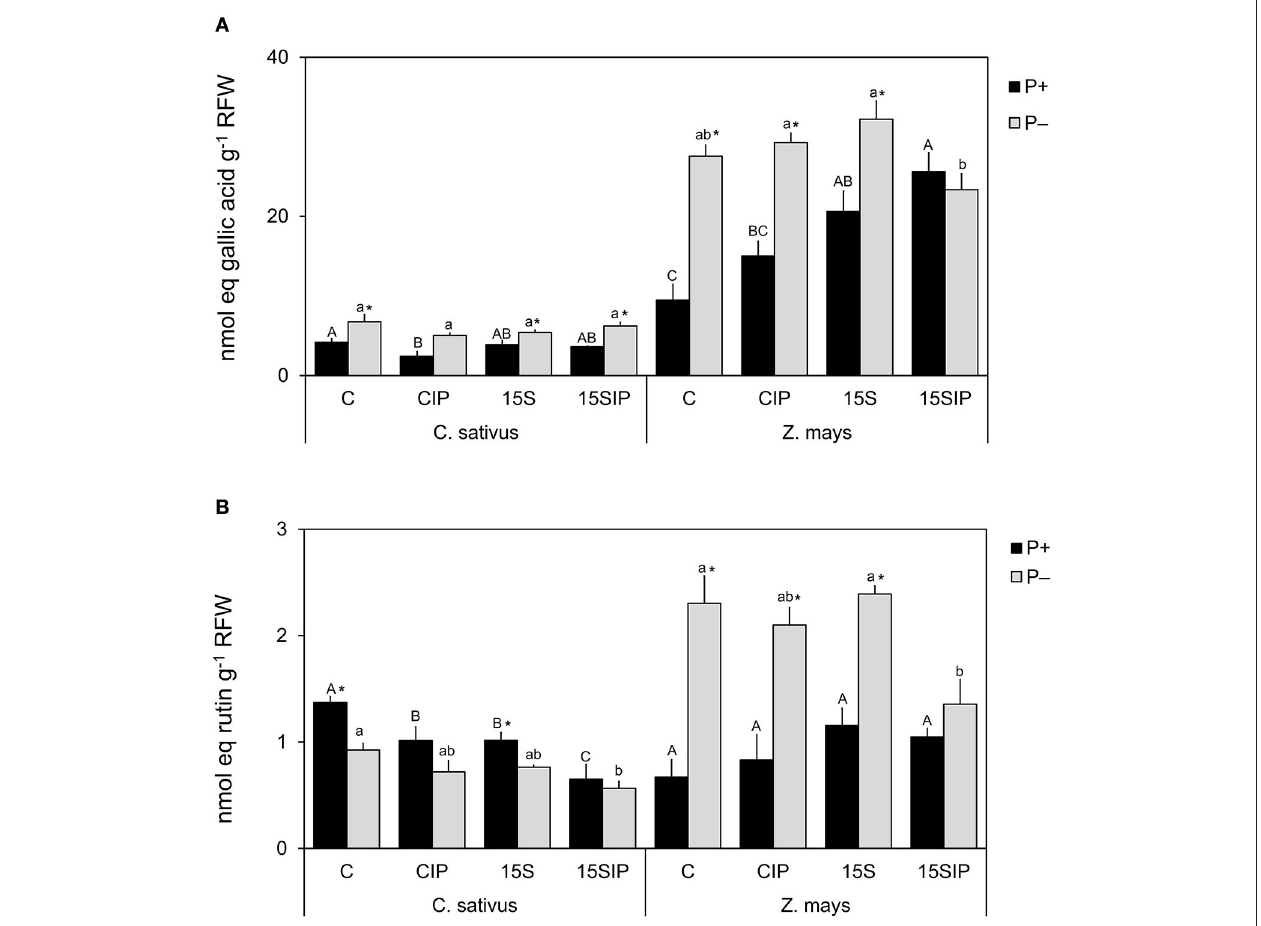
FIGURE 4 | Total phenolic compounds content (A) and total flavonoid content (B) determined in the root exudates of cucumber and maize collected at the end of the cultivation period. Values are means ± SE; n = 3. Capital letters compare treatments under P + , and lowercase letters compare treatments under P–. An asterisk is present when there is a difference in the same treatment between P + and P–. Equal letters correspond to average values that do not differ according to Tukey’s test ( p < 0.05). Two-way ANOVA results: Phenolic compounds: cucumber, P ( p < 0.001), I ( p < 0.01), P × I (NS); maize, P ( p < 0.001), I ( p < 0.001), P × I ( p < 0.001). Flavonoids: cucumber, P ( p < 0.001), I ( p < 0.001), P × I (NS); maize, P ( p < 0.01), I (NS), P × I ( p <